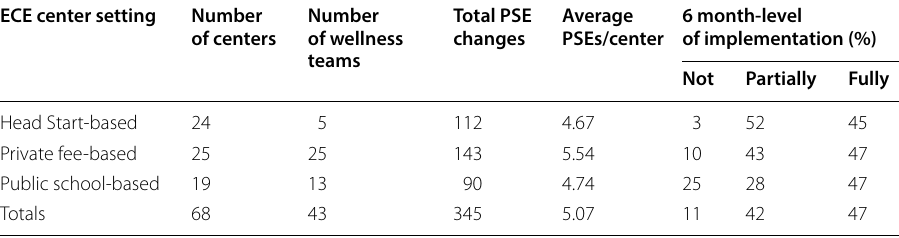
Table 5 Multivariable linear regression model: factors that predict the number of PSE changes implemented after completion of the PSE change process ( n